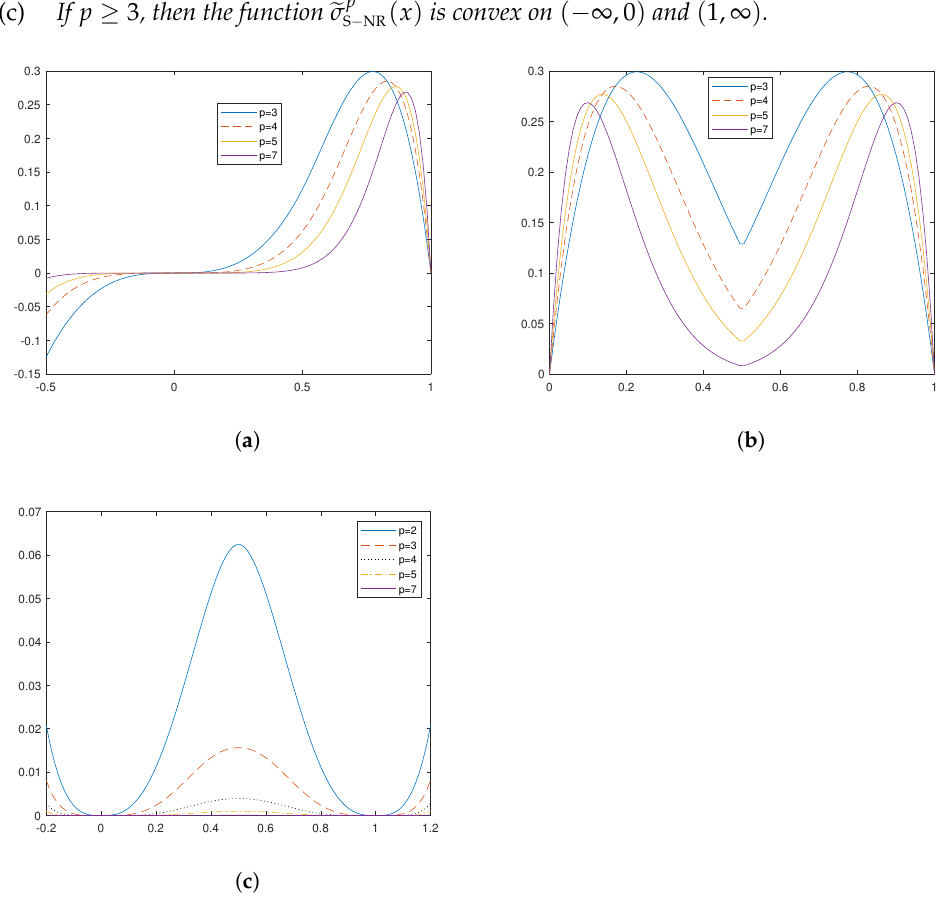
( x ) , (cid:101) τ p ( x ) and (cid:101) σ p with different values of p . ( a ) Graphs of (cid:101) τ p NR S − NR S − NR ( x ) with different values of p ; ( c ) Graphs of (cid:101) σ p S − NR